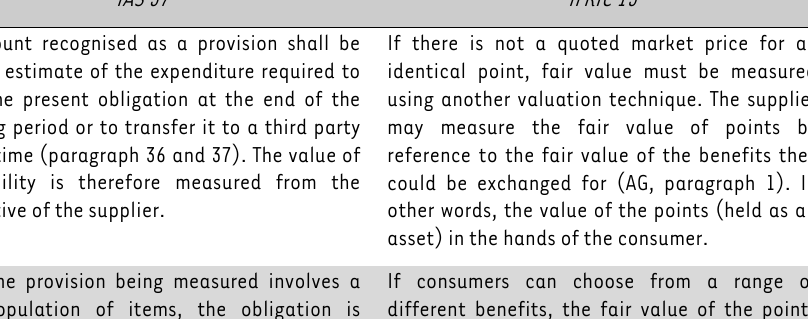
IAS 37 and IFRIC 13’s guidelines on determining the value of the deferred revenue (provision) IAS 37 IFRIC